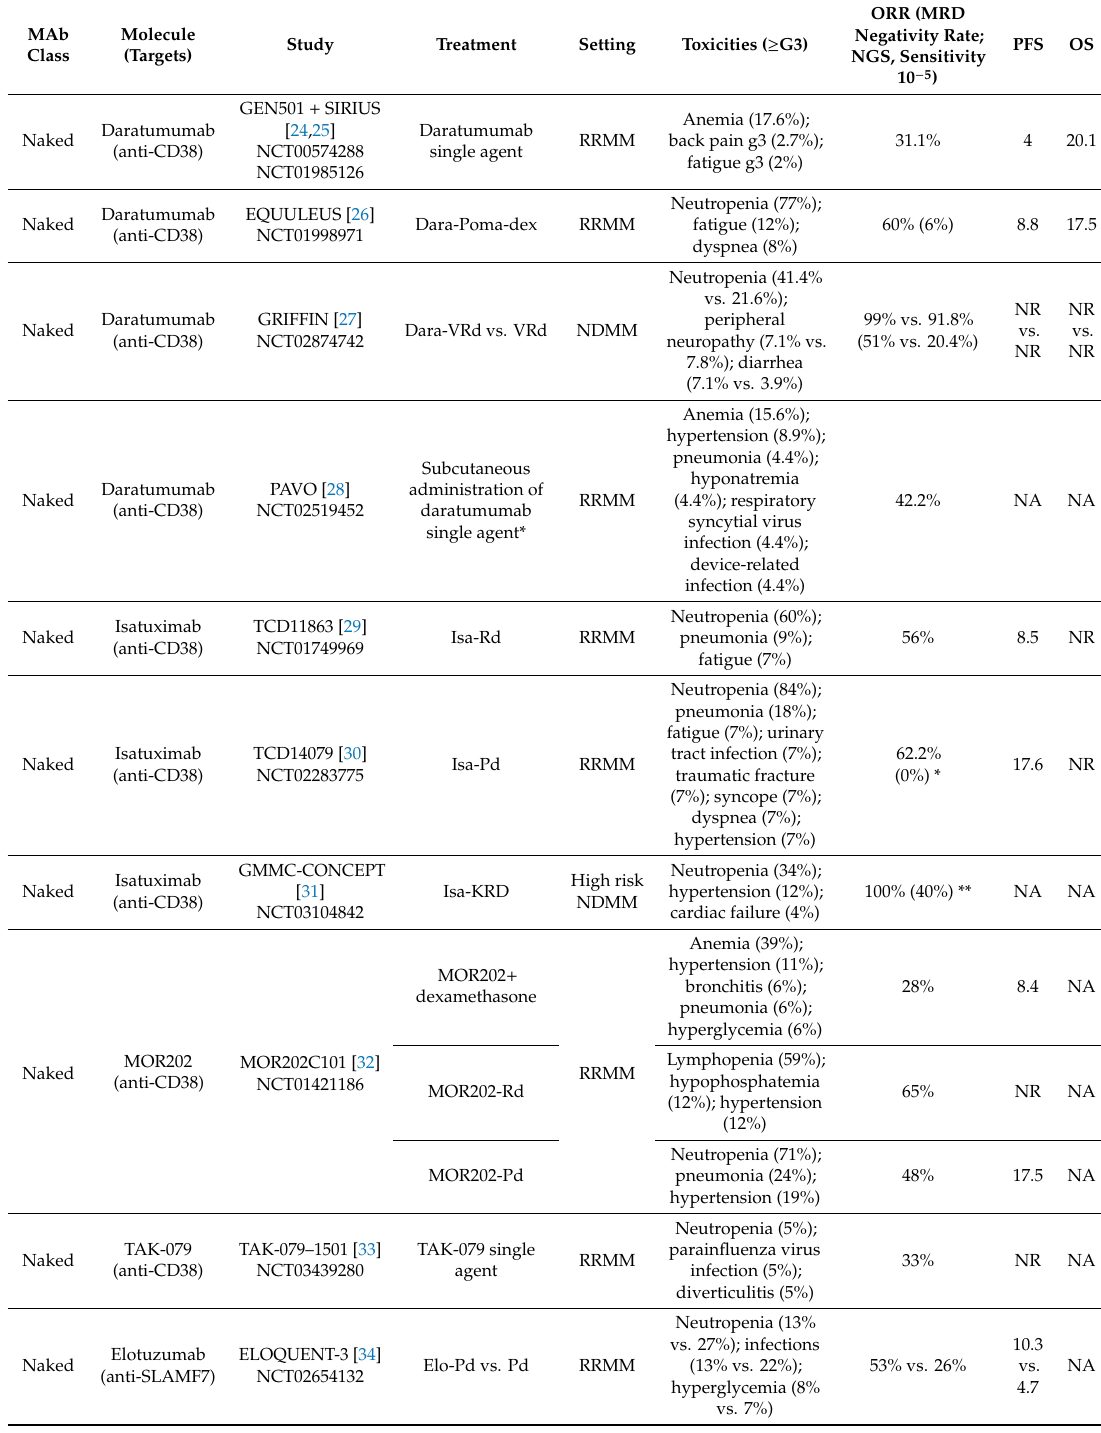
Table 1. List of phase I and II trials exploring mAbs in multiple myeloma